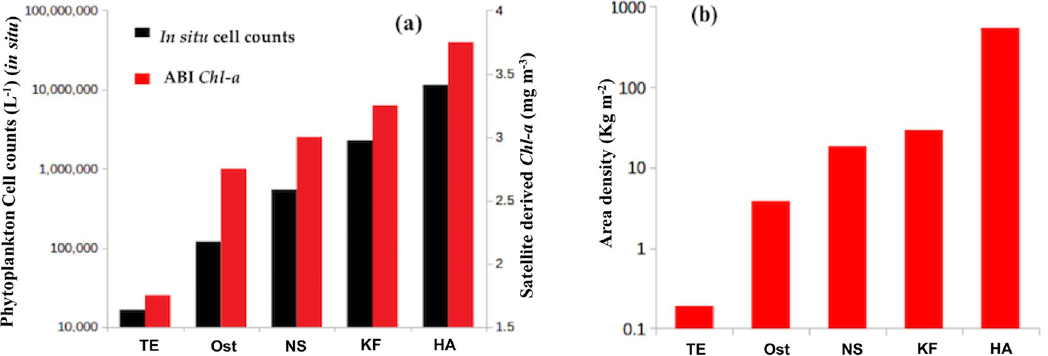
Fig 11. Remotely sensing Chl-a concentrations associated with different HAB species in the Red Sea and comparison with in situ phytoplankton cell counts. (a) Variations in total cell counts of harmful species and their satellite-derived Chl-a concentrations observed in the Red Sea. (b) Variations in the area density of remotely sensed HABs in the Red Sea. TE- Trichodesmium erythraeum ; Ost- Ostreopsis sp .; NS- Noctiluca scintillans ; KF- Kryptoperidinium foliaceum ; HA- Heterosigma akashiwo